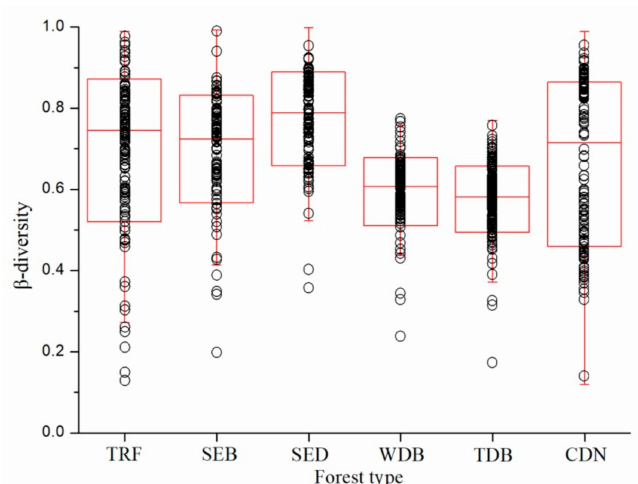
Figure 2. Soil fungal beta-diversity ( β -diversity) in six forest types along a latitudinal gradient. TRF, tropical rain forest; SEB, subtropical evergreen broad-leaved forest; SED, subtropical evergreen-deciduous broad-leaved mixed forest; WDB, warm-temperate deciduous broad-leaved forest; TDB, temperate needle-leaf and deciduous broad-leaved mixed forest; CDN, cold-temperate deciduous needle-leaf forest. The same for below.